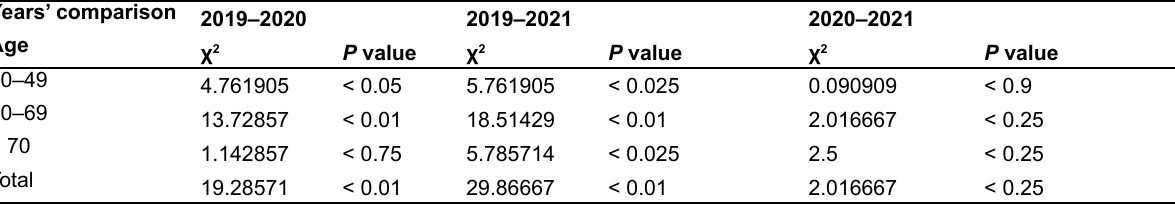
Figure 1. Box plot showing the distribution of BCs for ages per year. X-axis: years; Y-axis: number of BCs; X: mean Table 3. Statistical analysis of Pearson’s chi-squared test, divided for ages ranges